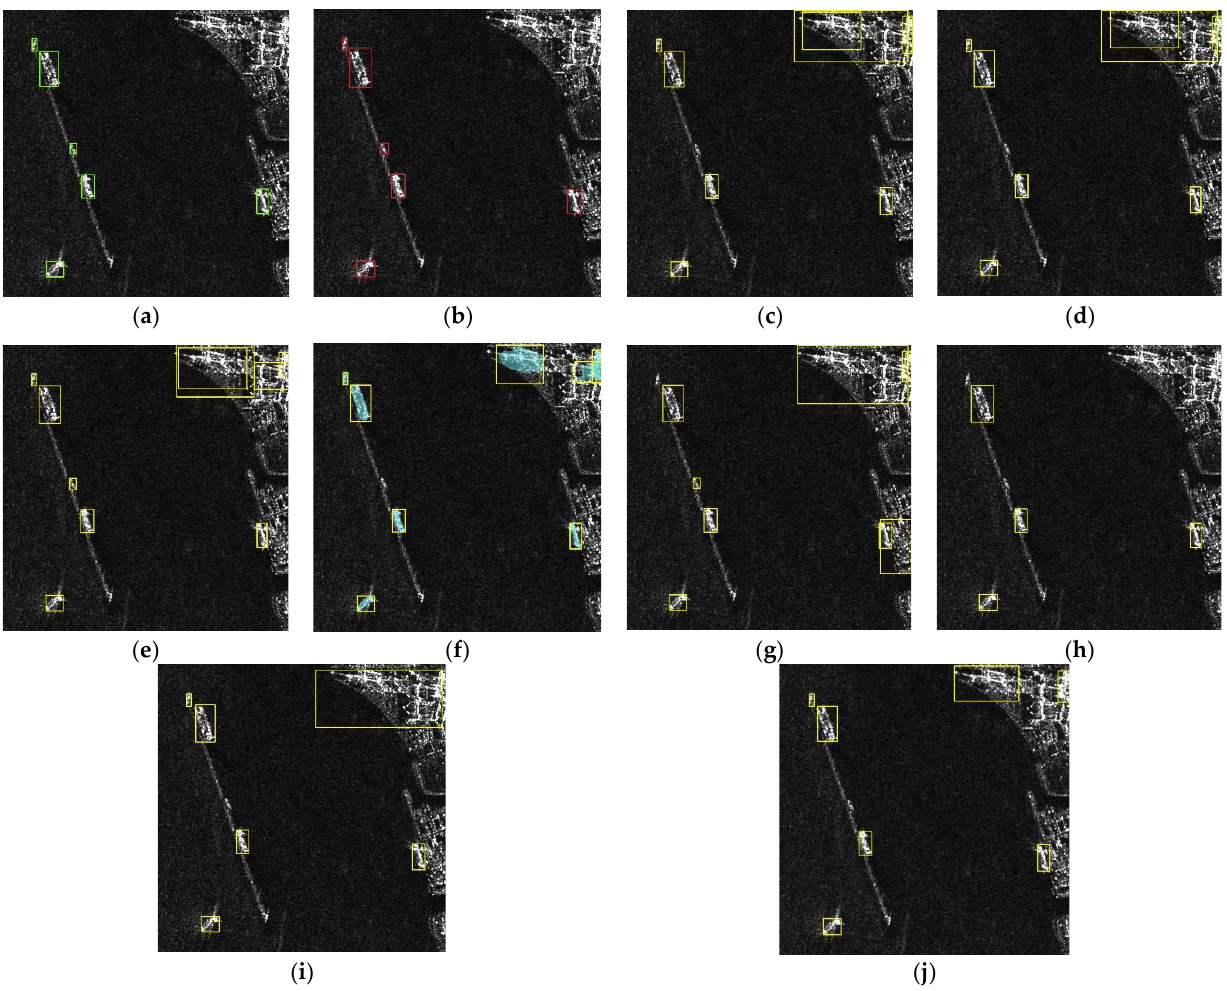
Figure 12. Partial detection results in HRSID, where the green boxes represent the ship positions marked in the dataset, the red boxes show the results detected by YOLO-SD and the yellow boxes represent the results inferred by other detection models. ( a ) ground truth; ( b ) YOLO-SD; ( c ) Dynamic R-CNN; ( d ) Faster R-CNN; ( e ) Grid R-CNN; ( f ) Mask R-CNN; ( g ) RetinaNet; ( h ) YOLOF; ( i ) YOLOv3; ( j ) Libra Faster R-CNN. Table 7 records the detection results obtained for YOLO-SD with other models. Only our algorithm succeeded in identifying not only the larger objects but also the smaller ships, without any false detection. In all the results, our model performs the best in terms of detection, even when compared to Mask R-CNN and Grid R-CNN (two models with high AP in Tables 4 and 5). Table 7. Specific detection results of Figures 11 and 12.